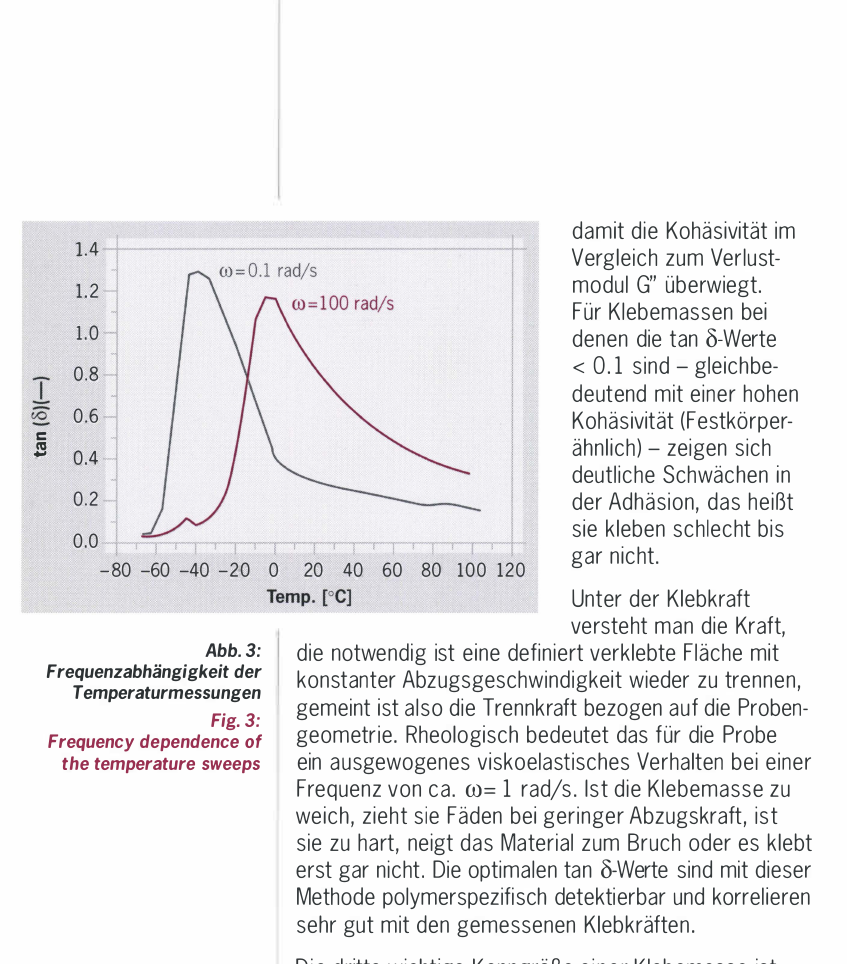
Two complex glass